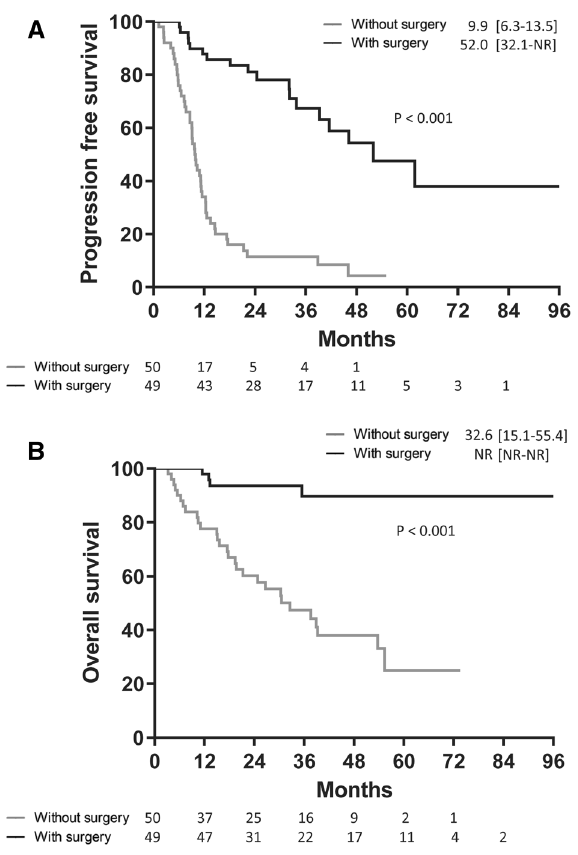
Figure 5. Progression-free survival ( A ) and overall survival ( B ) in patients with newly diagnosed EGFR mutation-positive non-small cell lung cancer with and without primary tumor